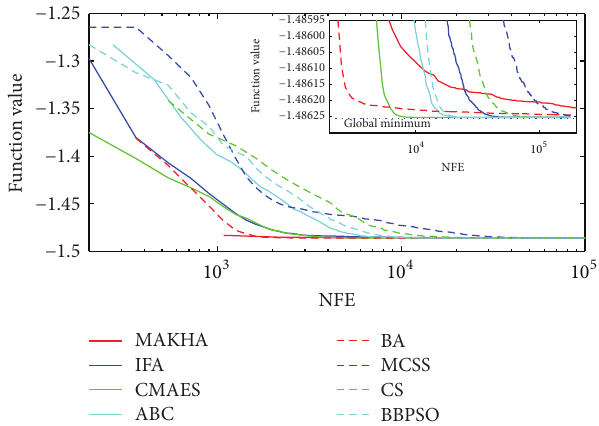
Figure 2: The evolution of the mean best value calculated via the eight metaheuristics versus NFE for problem